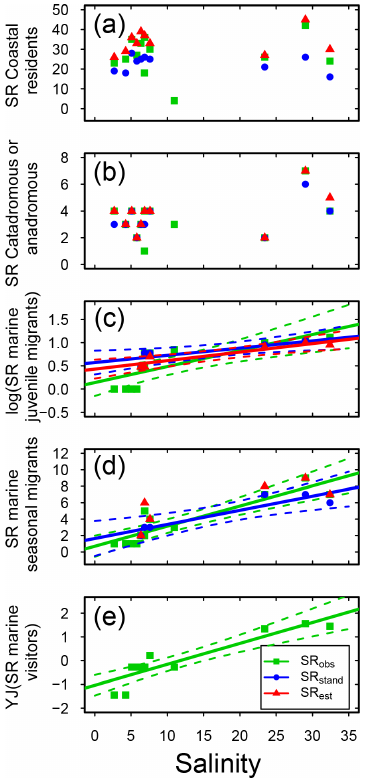
Figure 4. Fish species richness (SR) in relation to salinity in Swedish shallow coastal areas for different types of habitat pref- erence, with (a) coastal residents, (b) catadromous or anadromous migrants, (c) marine juvenile migrants (log 10 transformed), (d) ma- rine seasonal migrants, and (e) marine visitors (Yeo–Johnson trans- formed). Each plot shows the observed, standardized and estimated SR and, when significant ( P< 0 . 05), the linear regression lines (solid) and 95% confidence intervals (shaded areas surrounded by dashed lines). Please note that data points (Table S7), lines and shaded confidence intervals are overlying each other within the pan- els in some cases. For regression equations and statistics see Ta- ble 3. For marine visitors (e) , for clarity following transformation, only the observed SR is shown (no transformation was needed for the standardized and estimates values, and there were no significant relationships; Table